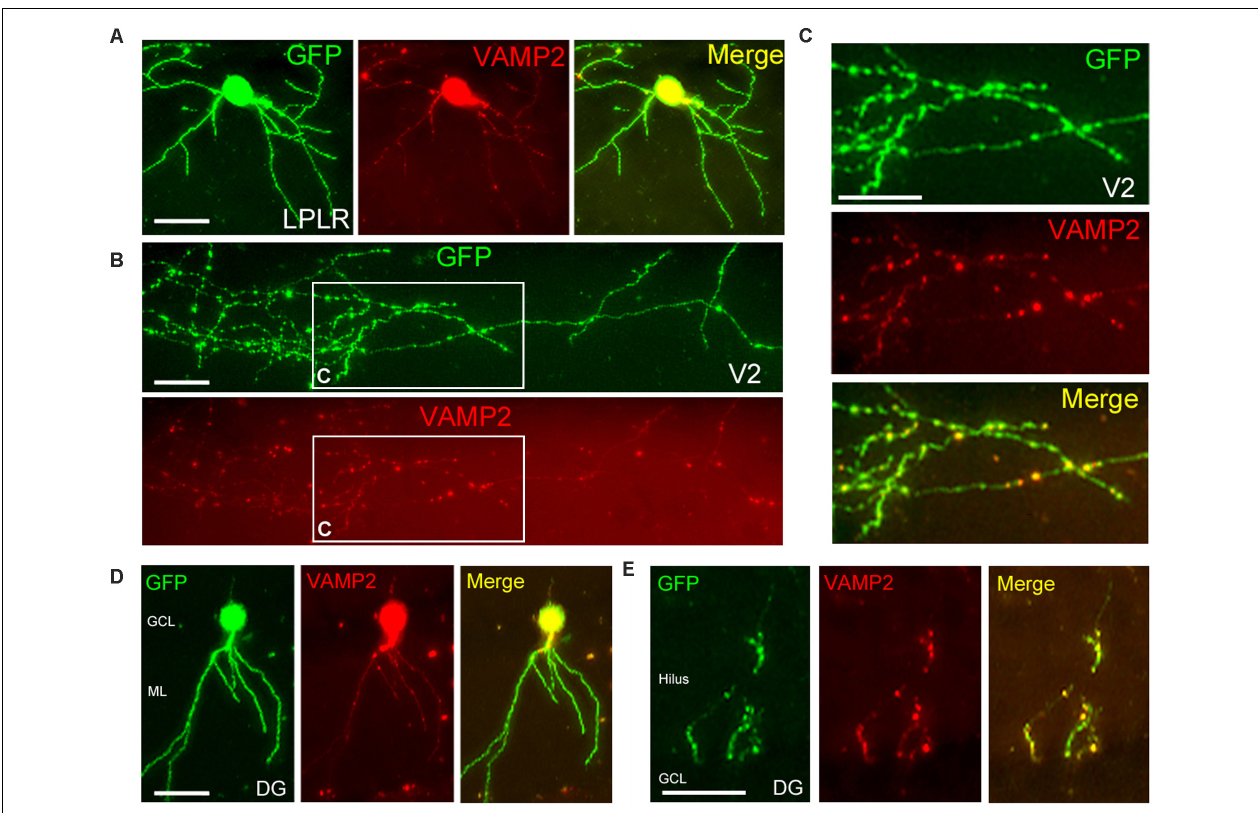
FIGURE 6 | Localized distribution of presynaptic proteins in vivo . (A–C) Distribution of GFP (green) and VAMP2-mOrange (red) in a single neuron of the laterorostral region of the LP (LPLR). VAMP2 fusion protein was expressed at a low level in a few dendrites (A) but accumulated in the thalamocortical axon (B) , particularly in terminal boutons in layer I of V2 ( C , higher magnification view of areas indicated in panel B ). (D,E) Localization of GFP and VAMP2-mOrange within a DG granule cell. As in the LPLR neuron, VAMP2 fusion protein was densely distributed in the axon (E) but sparse in the dendrites (D) . GCL, granule cell layer; ML, molecular layer. Scale bars, 50 µ m for panels (A,D,E) ; 25 µ m for panels (B,C)